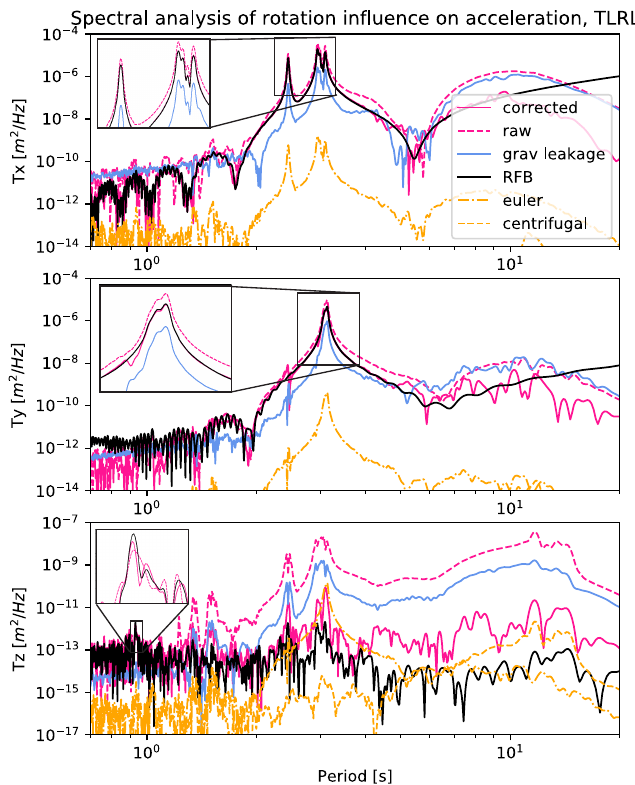
Figure 4. The figure includes six datasets; ‘raw’ is the EpiSensor data, ’corrected’ denotes the back rotated acceleration, ‘grav leakage’ is the rotated gravitational vector, ’RFB’ is the robot feedback and the two calculated apparent forces converted to displacements are denoted in yellow. The insets zoom into the key frequency peaks per